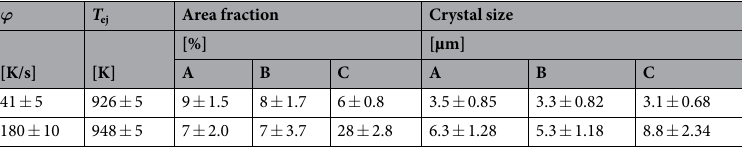
Table 1. Quantitative analysis of the microstructure of Cu 44 Zr 44 Al 8 Hf 2 Co 2 BMG composites containing B2 CuZr crystals and a glassy matrix. The area fraction and size of the B2 CuZr crystals are listed to indicate their dependence on the heating rate and location within the specimen. The average heating rate, ϕ ave , and ejection temperature, T ej , are given